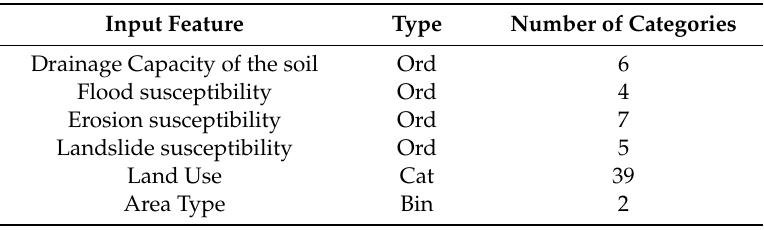
Table 3. Descriptive statistics of the categorical input